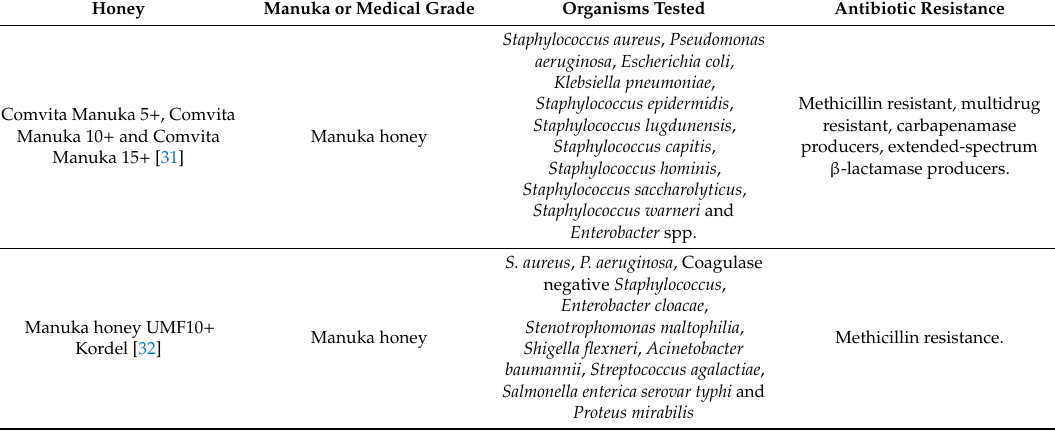
Table 1. Summary of the honey used in this review, the organisms tested and the antibiotic resistance of those